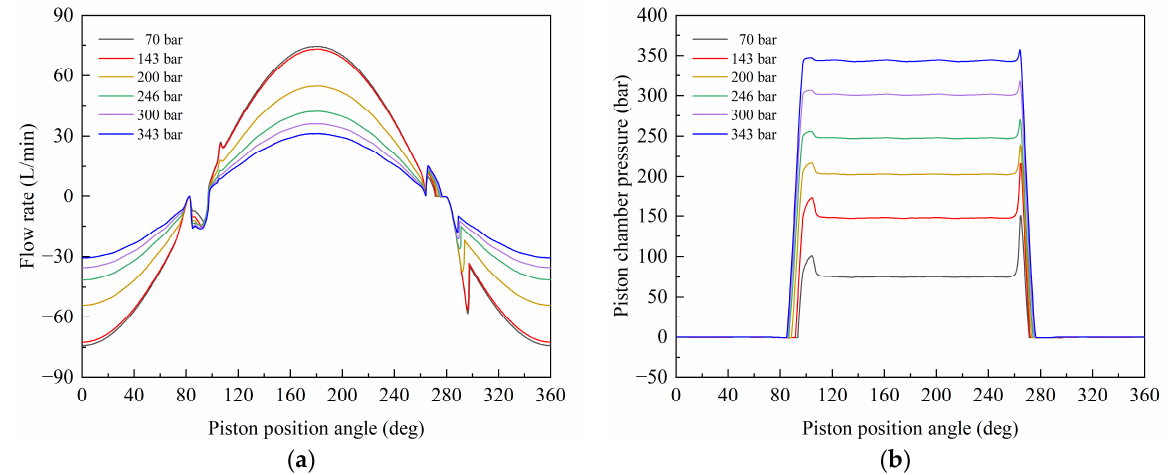
Figure 24. Flow and pressure characteristics of the piston chamber under different load pressures: ( a ) dynamic flow; ( b ) dynamic pressure.